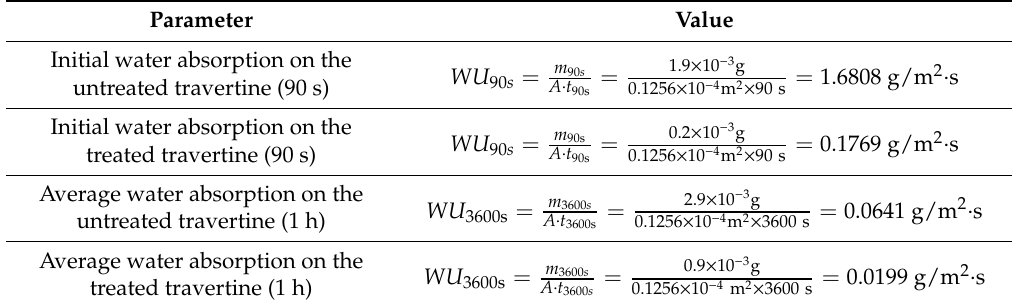
Table 6. Water absorption (initial and average) calculated using the Karsten pipe method for both coated and uncoated travertine.